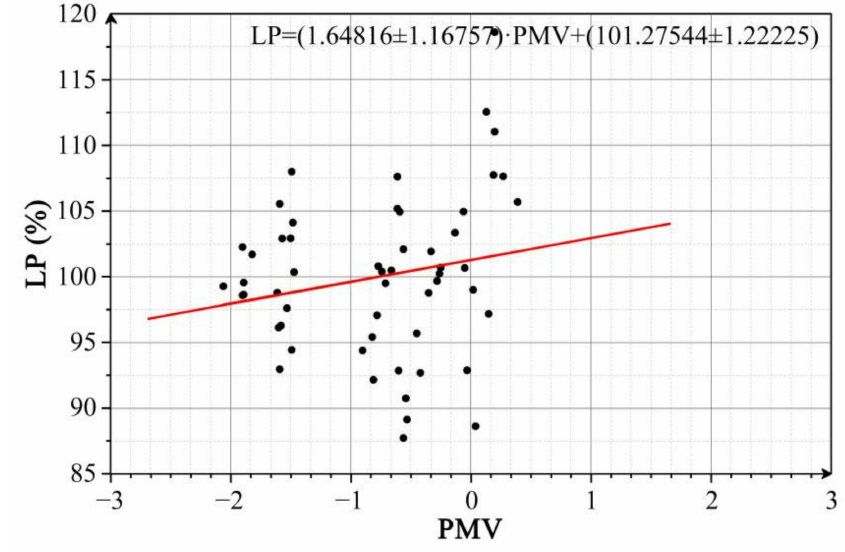
Figure 22. The quantitative relationship between PMV and LP. Thirdly, the relationship between TAV and LP is indicated in Figure 23. It can be clearly seen that the TAV of the tested students showed a linear relationship with LP. When the TAV changed from “Very Dissatisfied” ( − 3) to “Very Satisfied” (+3), the LP showed an increasing trend, indicating that the higher the TAV, the better the